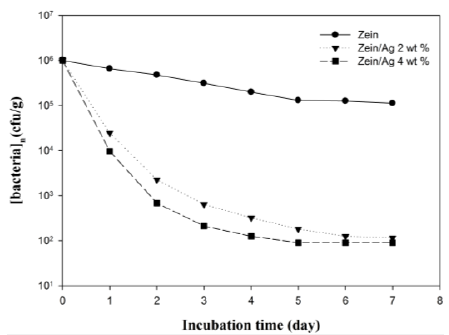
Figure 6. Antibacterial ability against Staphylococcus aureus . ( a ) blank and with zein/Ag nanoparticles containing Ag concentrations of ( b ) 0 wt %; ( c ) 2 wt %; and ( d ) 4 wt % (after one week).